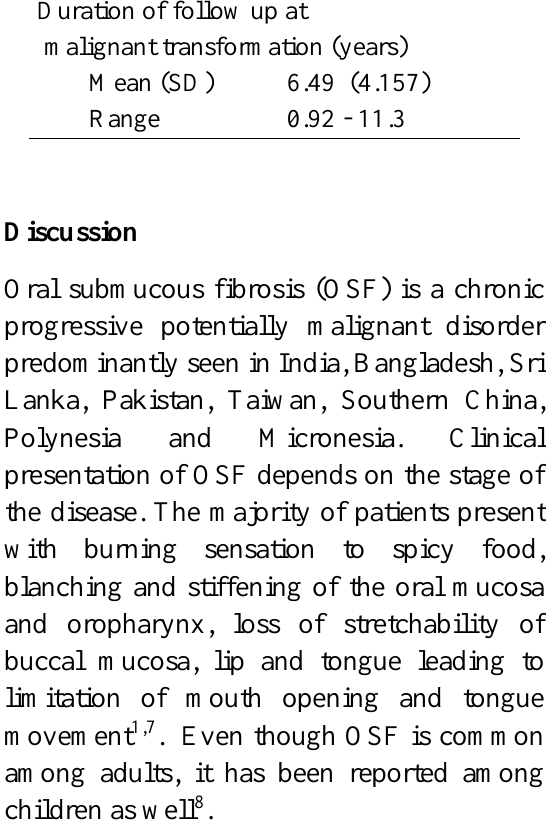
Duration of follow up at malignant transformation